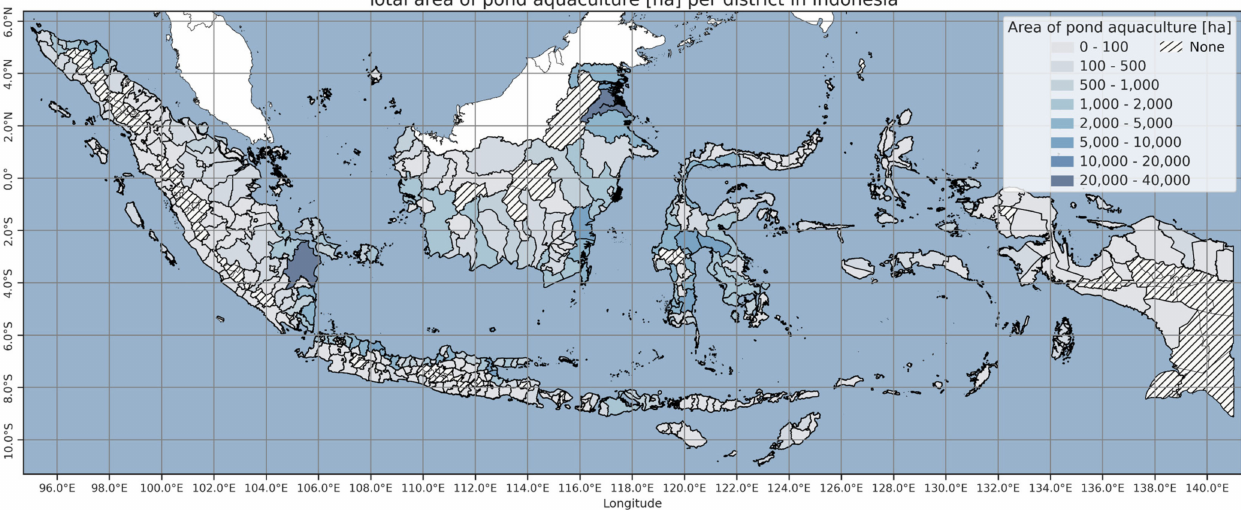
Figure 12. Mapping result: total pond aquaculture area for Indonesia at district